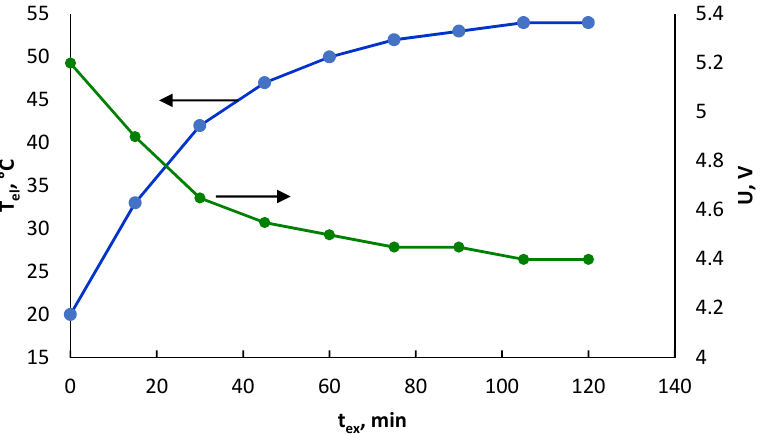
Figure 11. Electrolyte temperature and cell voltage versus the experiment duration. Experimental conditions: Raw material—fraction [A], C HCl = 6 M, i = 0.66 A·cm –2 , and S/L = 8.6 g·L –1 .